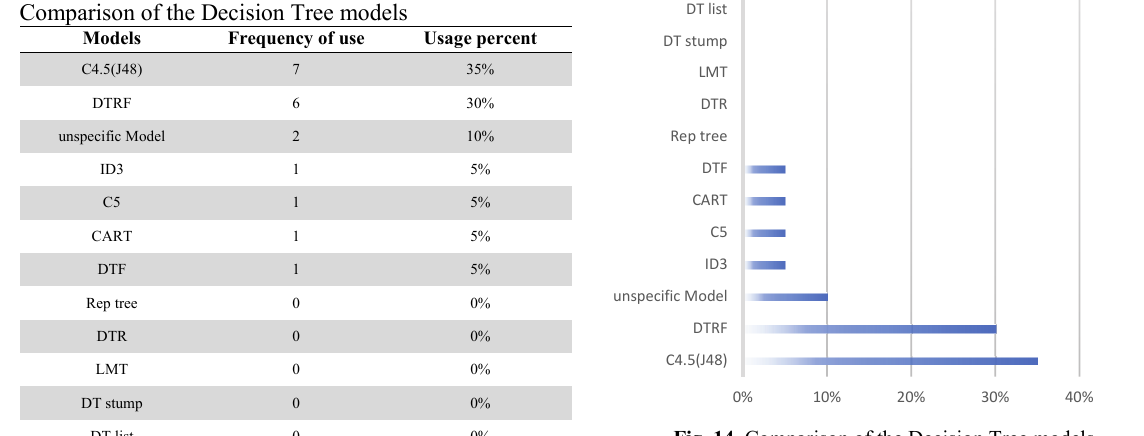
Fig. 14. Comparison of the Decision Tree models